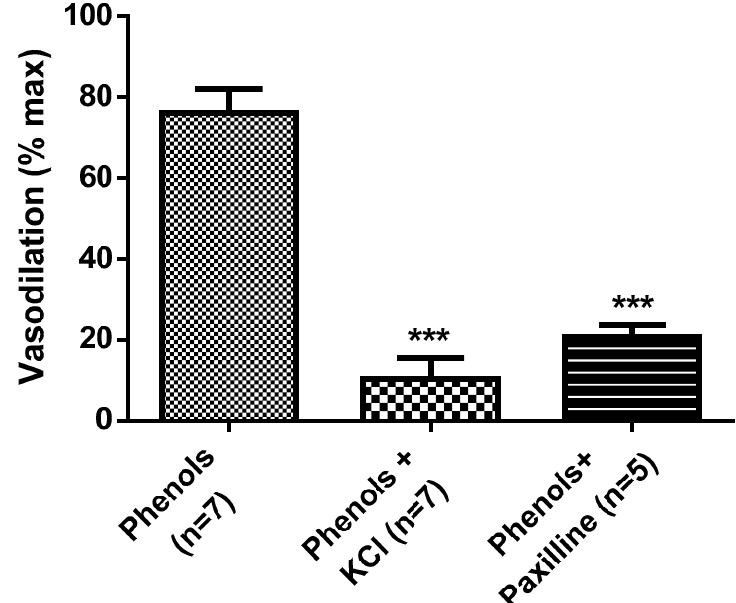
Figure 5. Extra virgin olive oil phenol-induced vasodilation is mediated by hyperpolarization. Phenols from crude extra virgin olive oil were tested at 3 × 10 − 5 M on isolated resistance mesenteric arteries in the absence (phenols) or presence of the BK Ca2 + channels inhibitor, paxilline (10 µ M, phenols + paxilline). Further, Phenols were tested also on mesenteric arteries depolarized by KCl (40 mM, phenols + KCL). Data are reported as the mean ± SEM, n (experimental number). Statistical analysis was performed using Student’s t-test, *** p < 0.001.